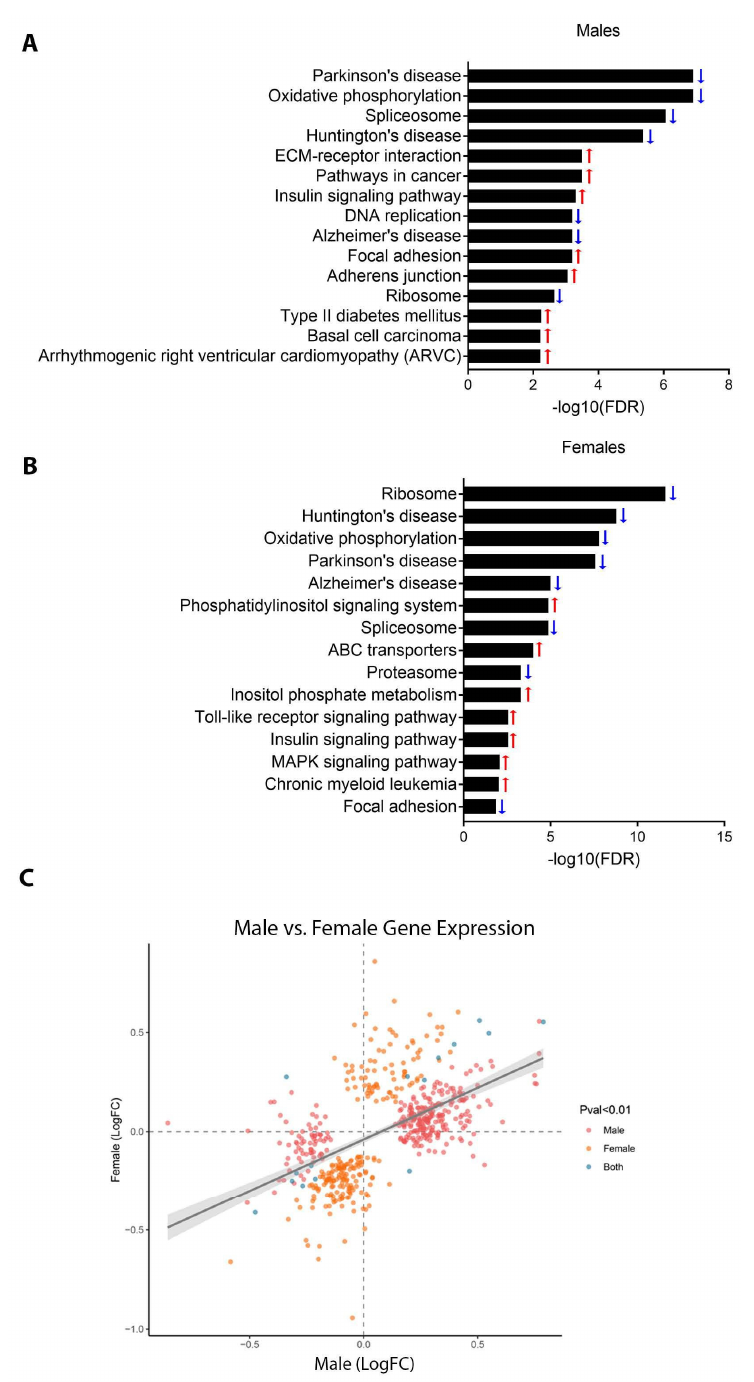
Figure 3. RNA-seq data in weanling mouse hearts. ( A , B ) Results of KEGG pathway analysis of RNA-seq data, showing the top 15 most significant pathways for males ( A ) and females ( B ). Pathways are listed in order of decreasing significance from top to bottom (i.e., smallest to largest FDR). Blue and red arrows indicate reduced and increased expression of the pathway, respectively. ( C ) Scatter plot of all genes differentially expressed (DE) with Pb exposure with a p -value < 0.01, depicting correlations in log2 fold change with Pb exposure between males and females. Pink, orange and blue dots depict DE genes with a p -value <0.01 in males, females, or both, respectively. The p -value for correlation between males and females was determined using Pearson’s product-moment